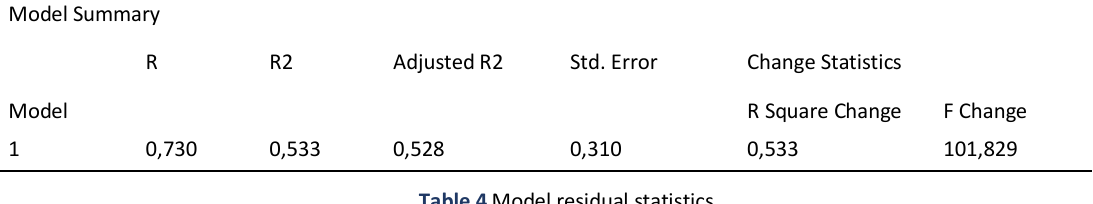
Table 4 Model residual